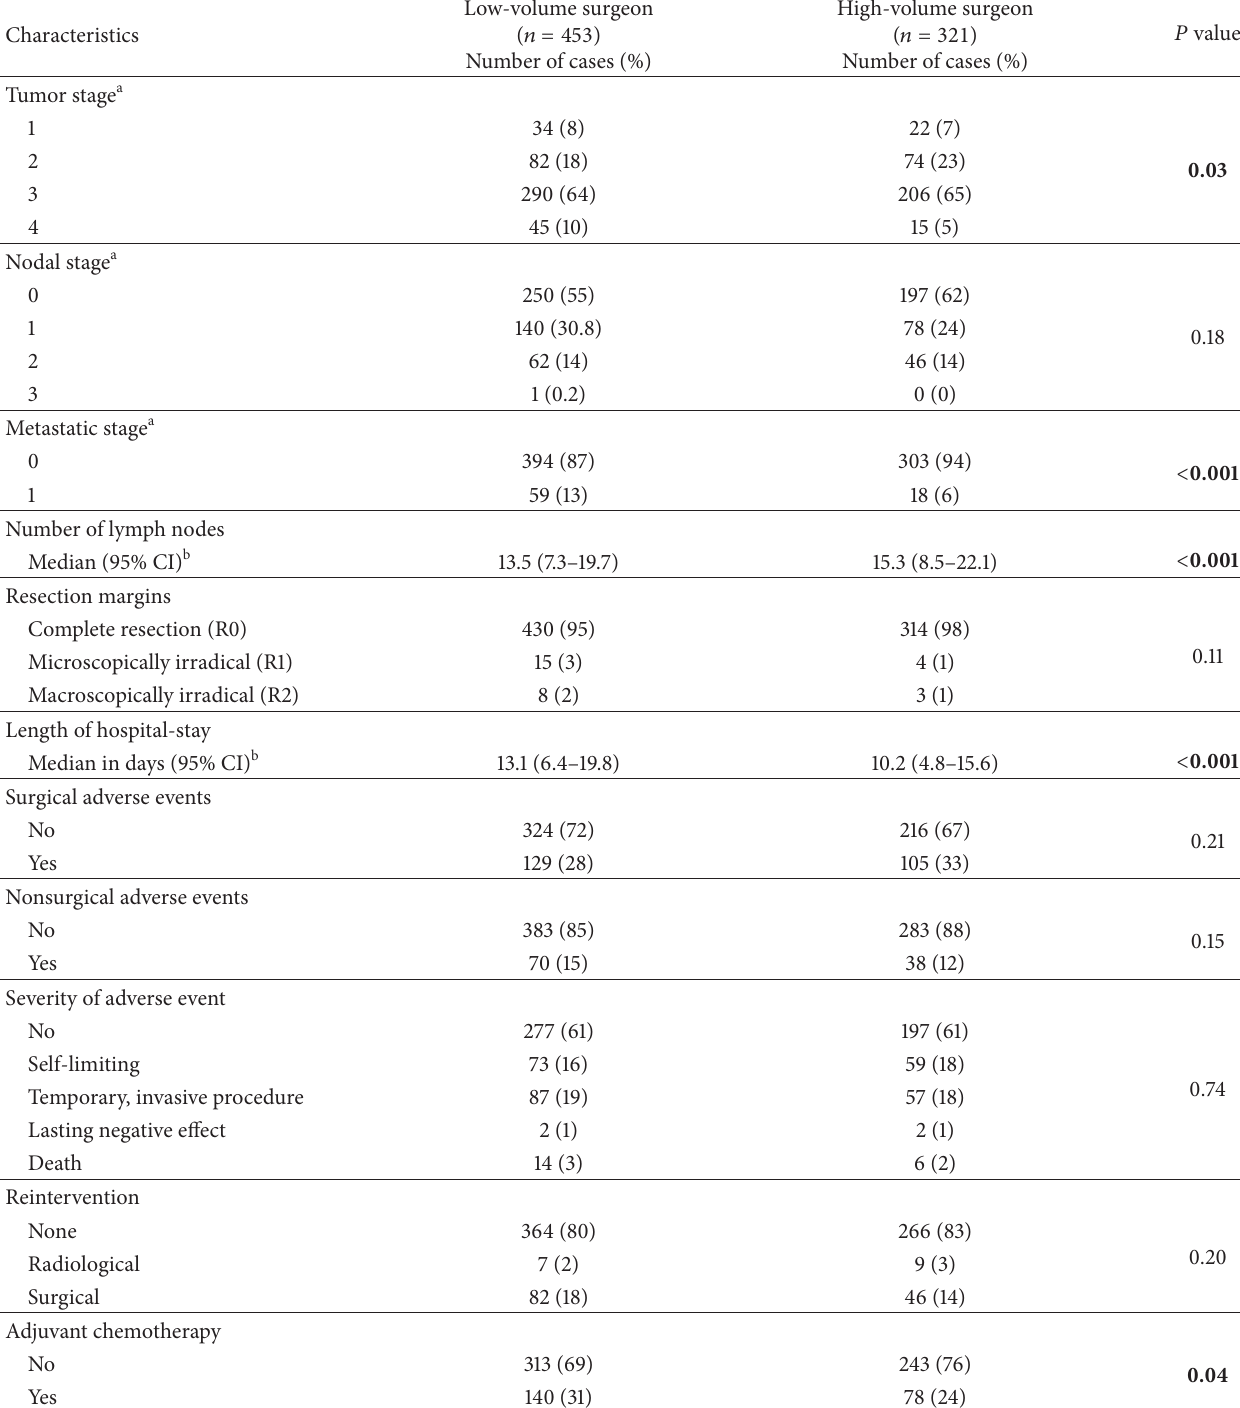
Table 3: Postoperative